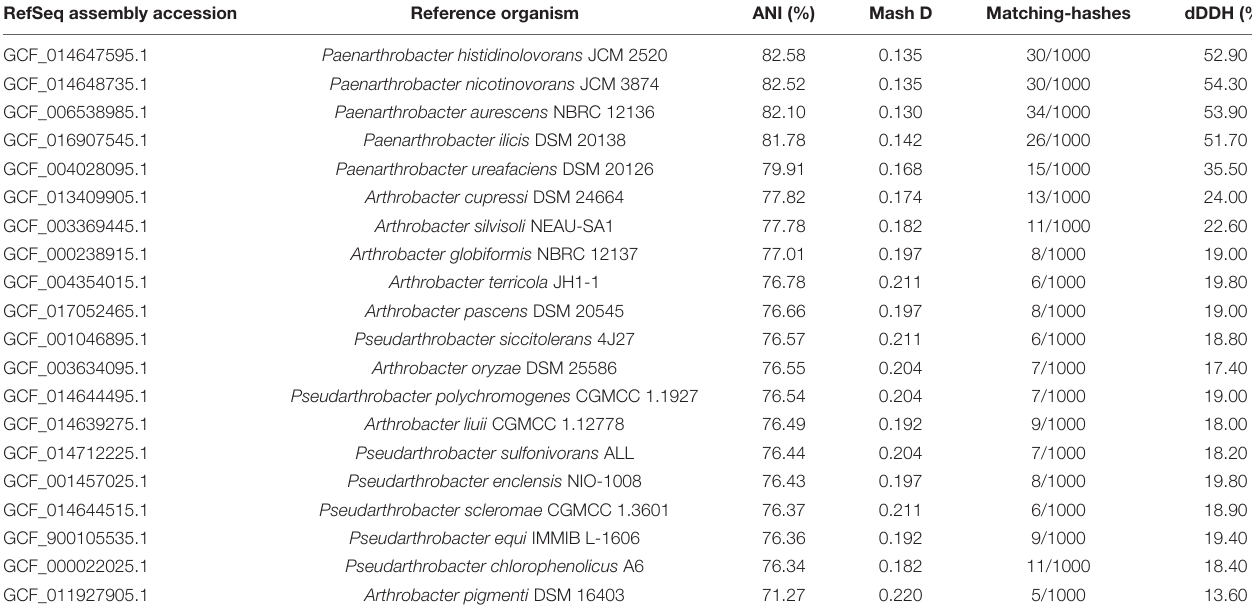
TABLE 1 | Pairwise comparisons of Paenarthrobacter sp. GOM3 against closets type strain genomes according to several overall genome relatedness indexes (Mash D, ANI, and digital DNA-DNA hybridization